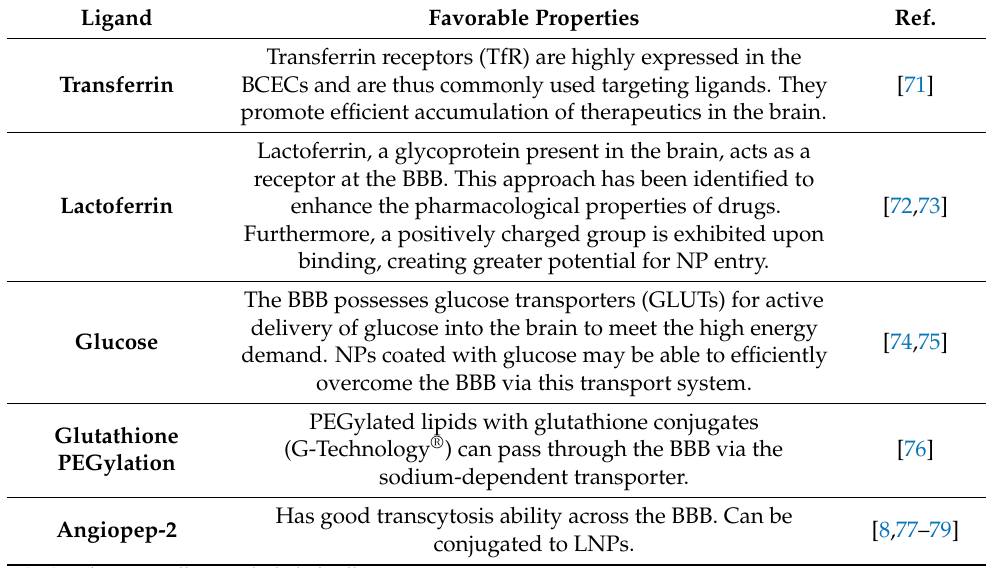
Table 3. Some surface modifications to NPs for targeting the brain and increasing